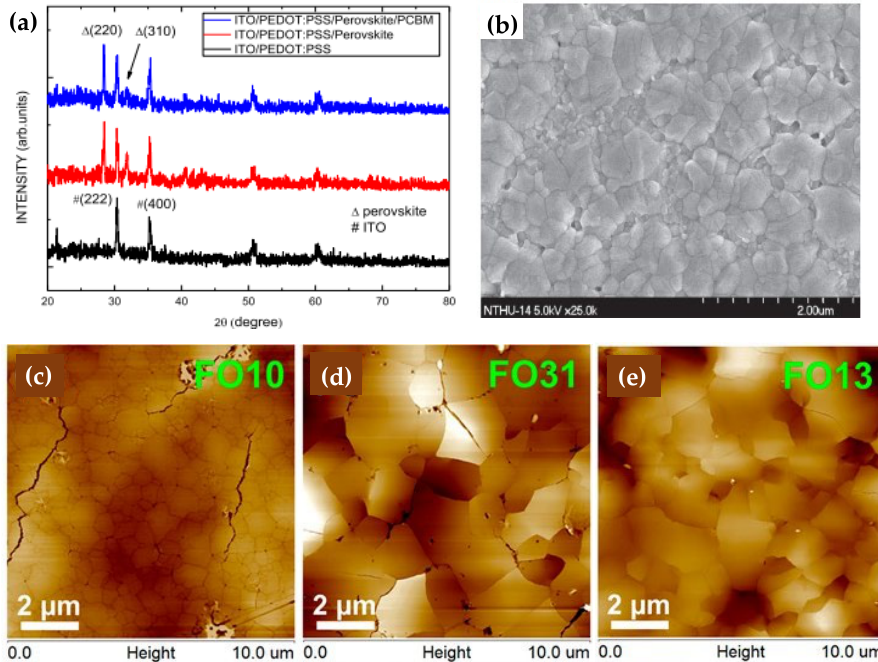
Figure 11. ( a ) X-ray diffraction patterns; ( b ) SEM micrograph; ( c – d ) AFM images [39,62].